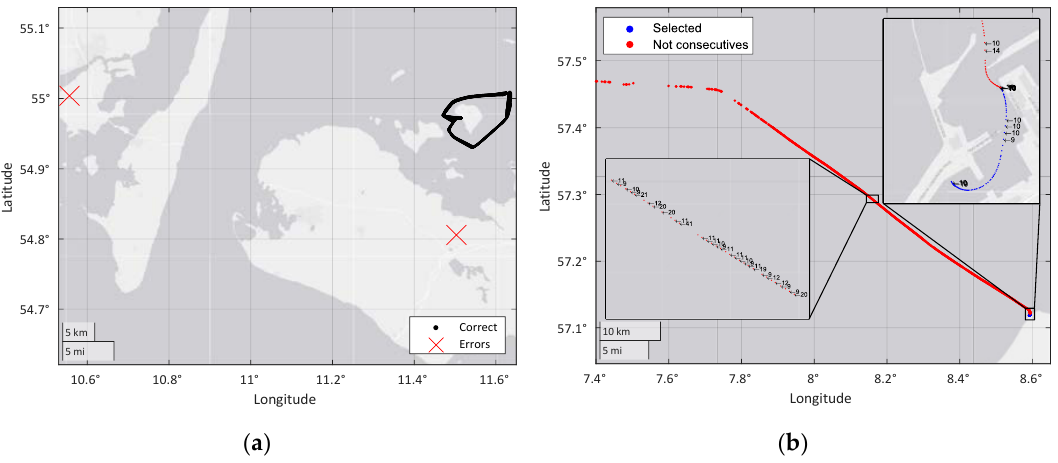
Figure 2. ( a ) Example of extreme noise. ( b ) Example of the time gap problem.